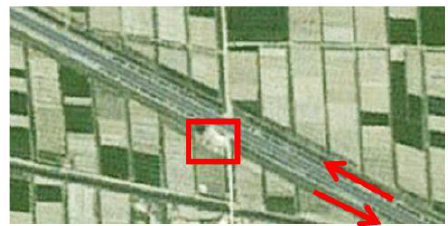
Figure 18. Ortho image of the Changji highway in aerial imagery.